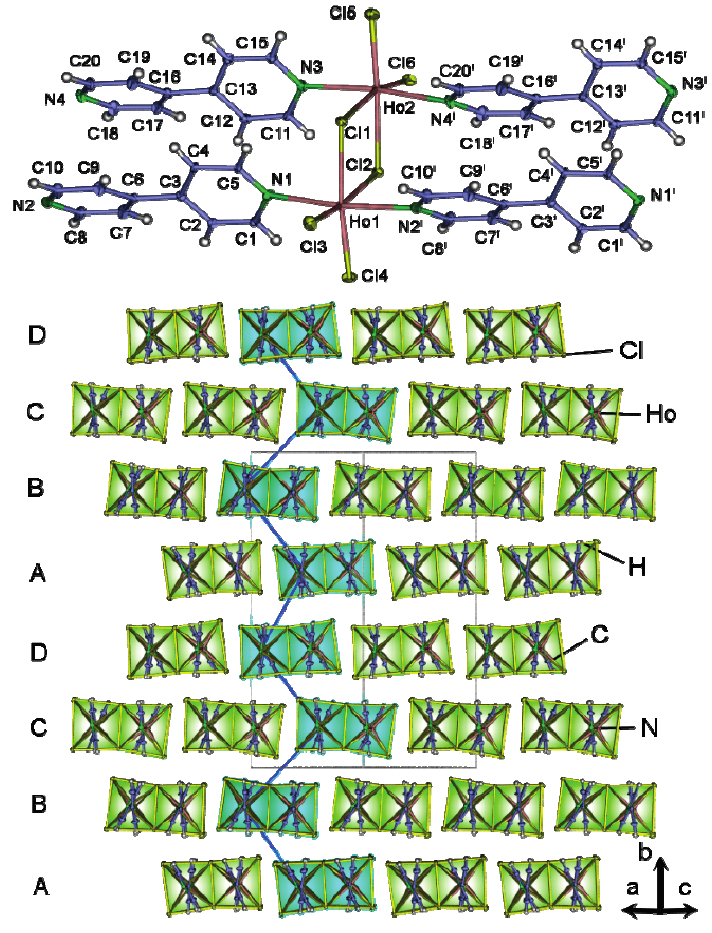
Figure 10. Extended coordination sphere with ligands of 1 ∞ [Ho 2 Cl 6 (bipy) 2 ] ( 11 ); thermal ellipsoids are depicted with 50% probability; symmetry operators: I 1+x, +y, − 1+z ( top ). View along [101] parallel to the ladder like strands of 1 ∞ [Ho 2 Cl 6 (bipy) 2 ]; the stacking order is marked in blue ( bottom